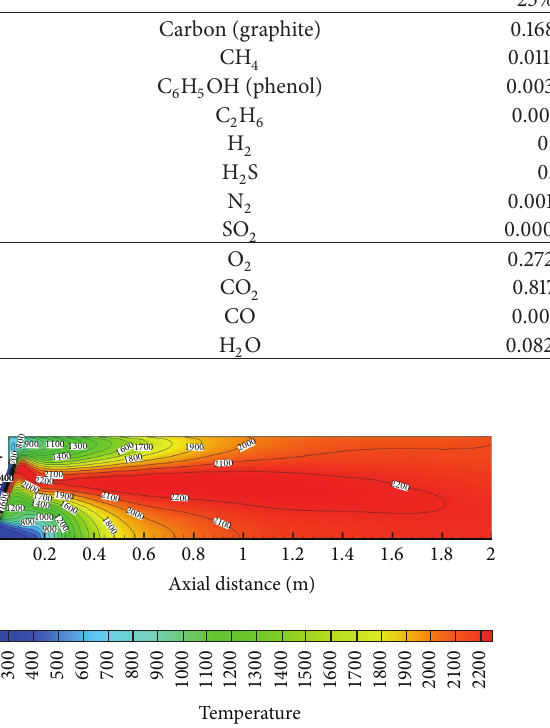
Figure 2: Predicted temperature contours for OF50 case.